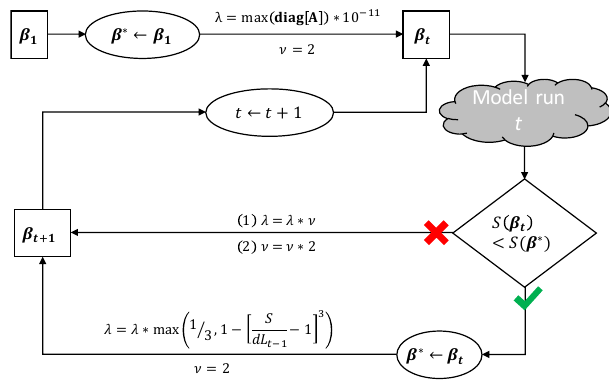
Figure A2. Method for updating λ , after Nielsen (1999,